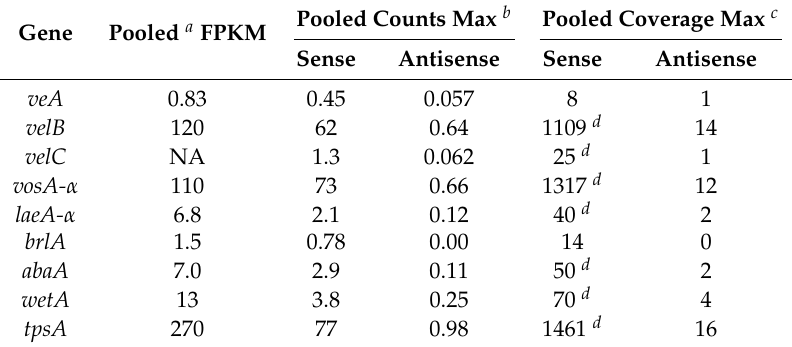
Table 3. Pooled transcript accumulation of the velvet family members and core regulators of conidiation under enhanced butyrolactone I biogenesis a . Gene Pooled a